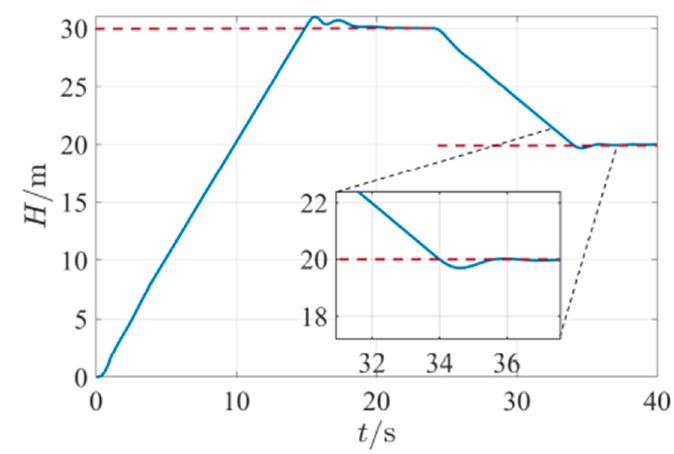
Figure 15. The evolution of height vs. time.